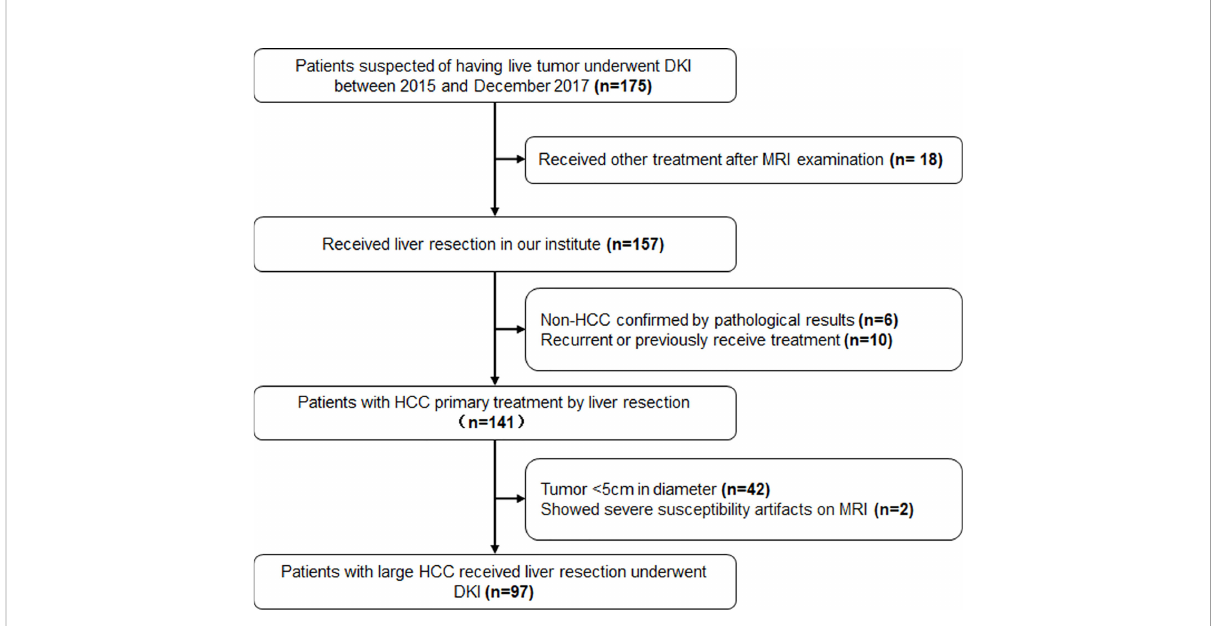
FIGURE 1 The fl owchart of patients ’ selection. DKI, Diffusion Kurtosis Imaging; HCC, Hepatocellular